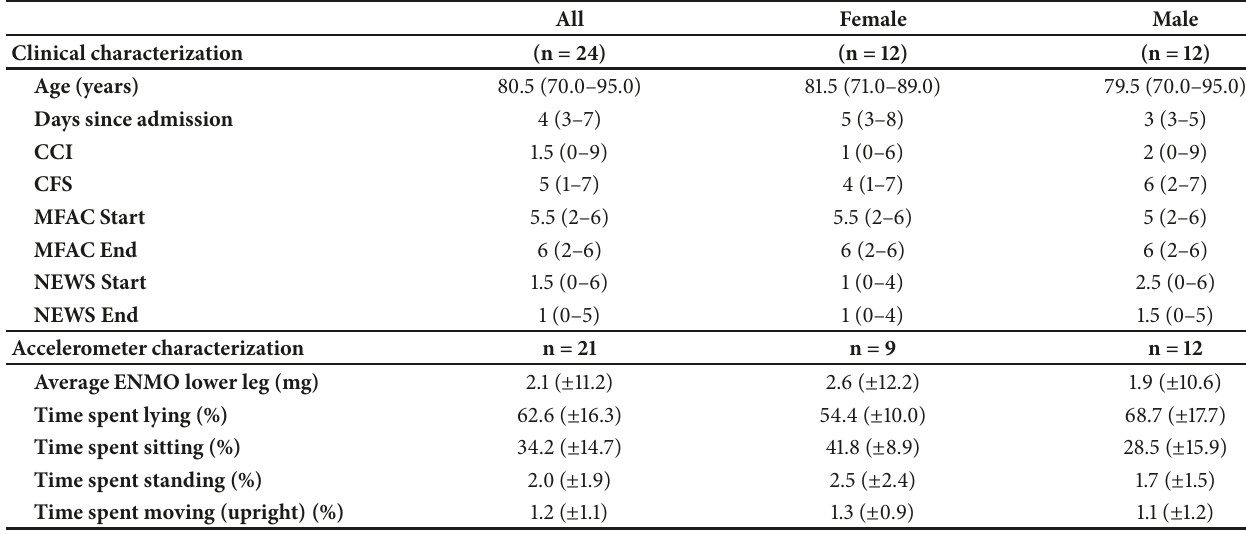
Table 1: Participant